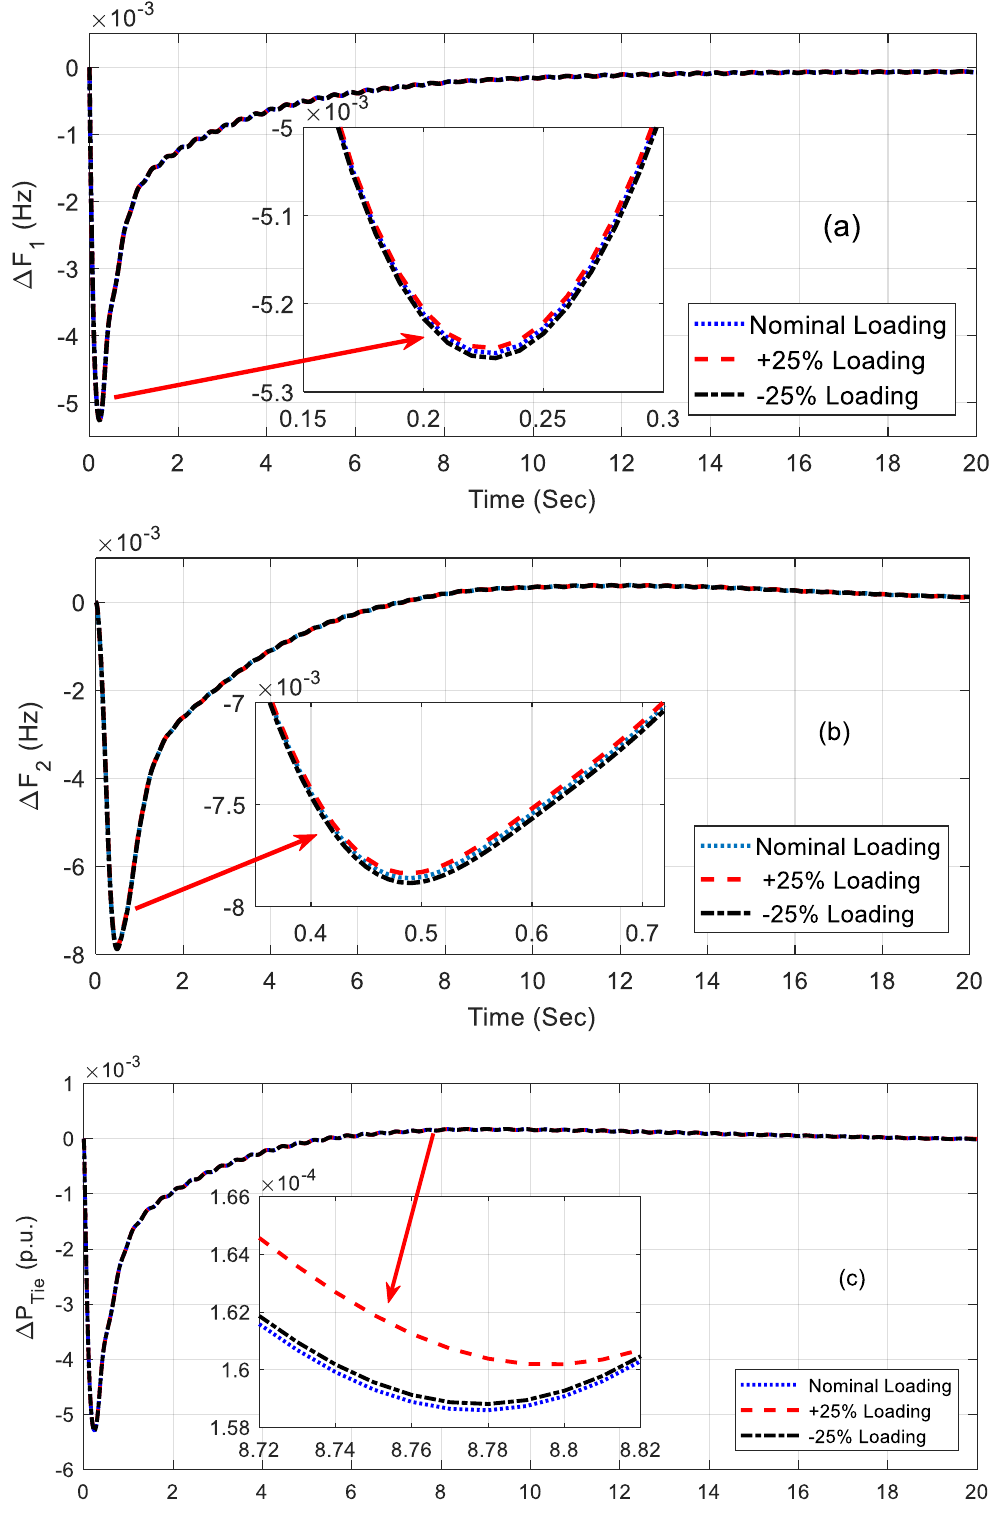
Figure 8. ( a – c ) Responses under loading variation.